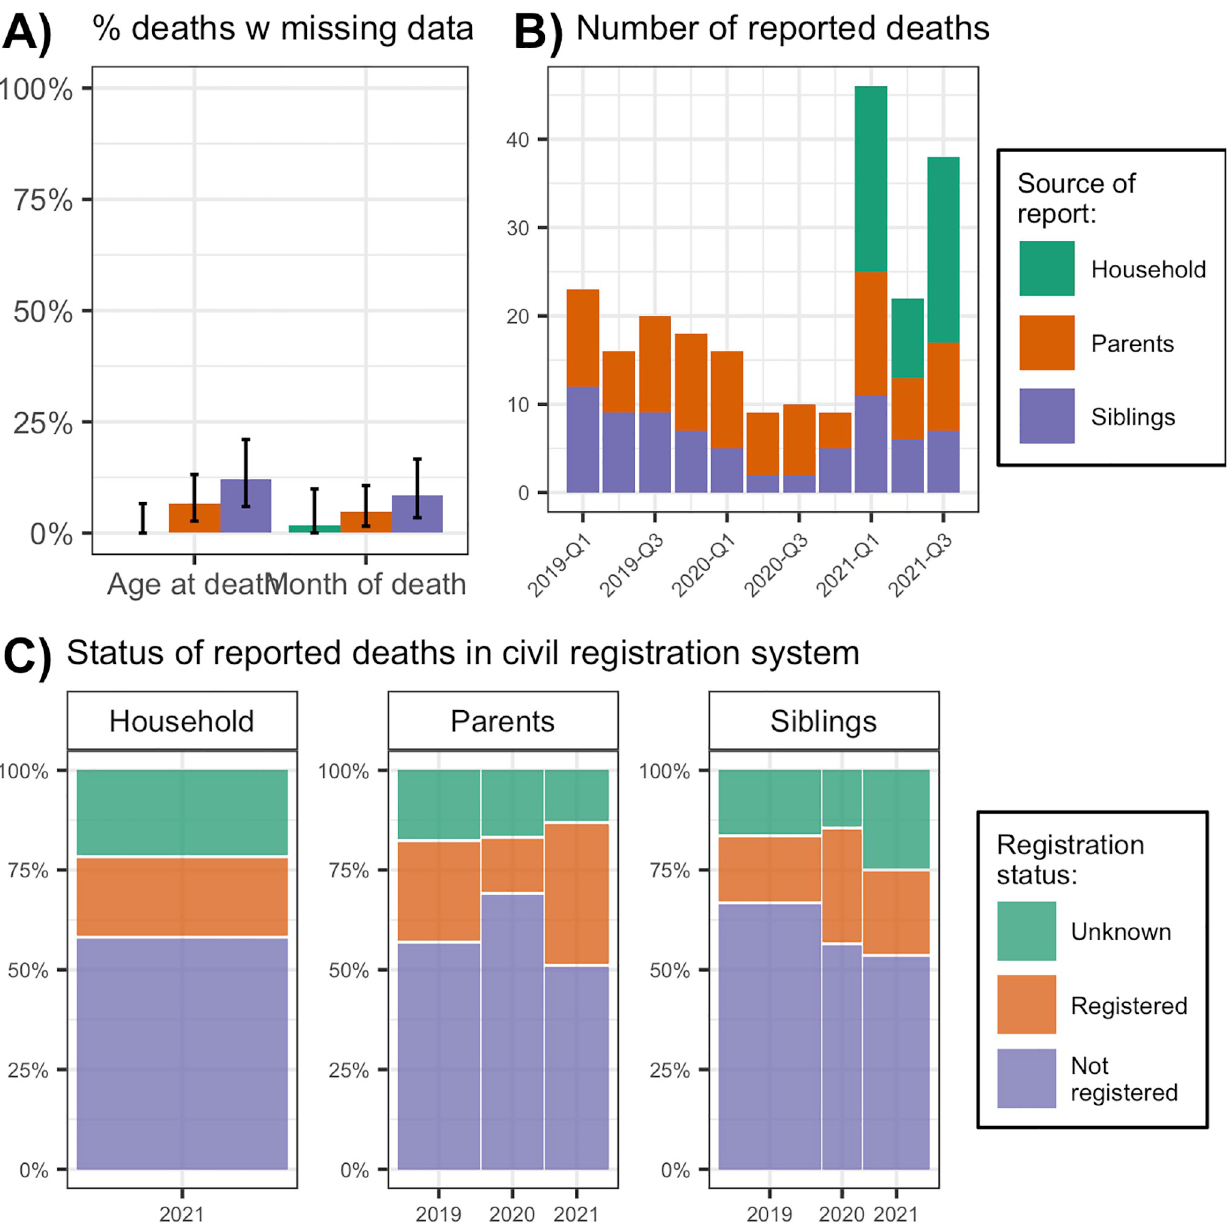
Fig 5. Exploratory assessments of the quality of reported data on recent deaths. Notes : In Panel A), error bars represent 95% exact confidence intervals. The difference in the likelihood of missing data on age at death by source of report was significant at the p < 0.05 level. In Panel B), Q1 refers to the first quarter of a year, i.e., January, February and March. Two deaths reported to have occurred in October 2021 by respondents interviewed after October 1 st , 2021 were omitted from the plot. Household deaths were only elicited for the period between the start of 2021 and the survey data. In Panel C), the width of each bar is proportional to the number of deaths reported in each